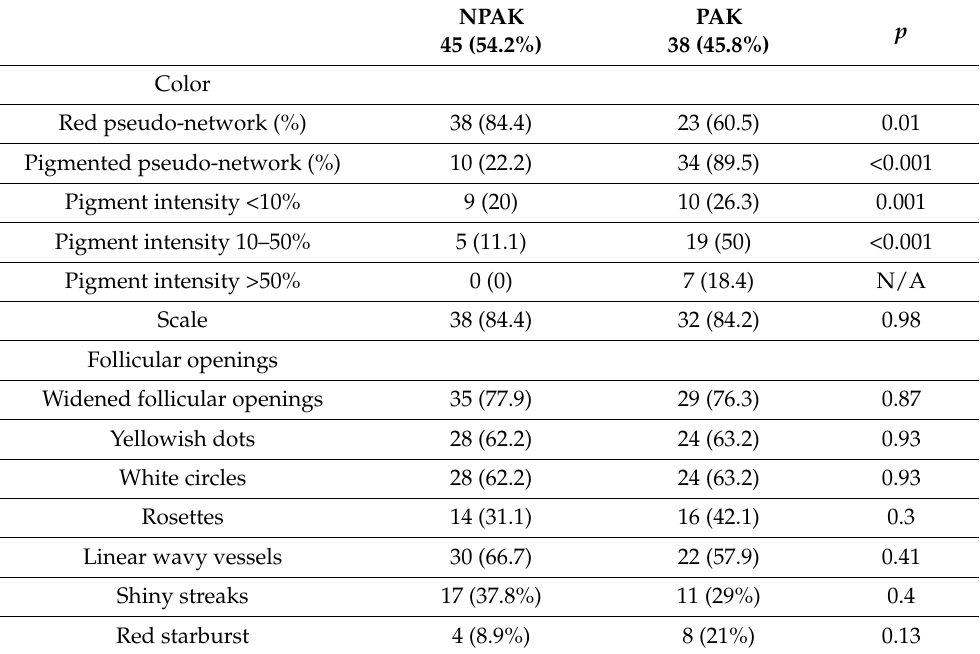
Table 2. Dermoscopic features of NPAK and